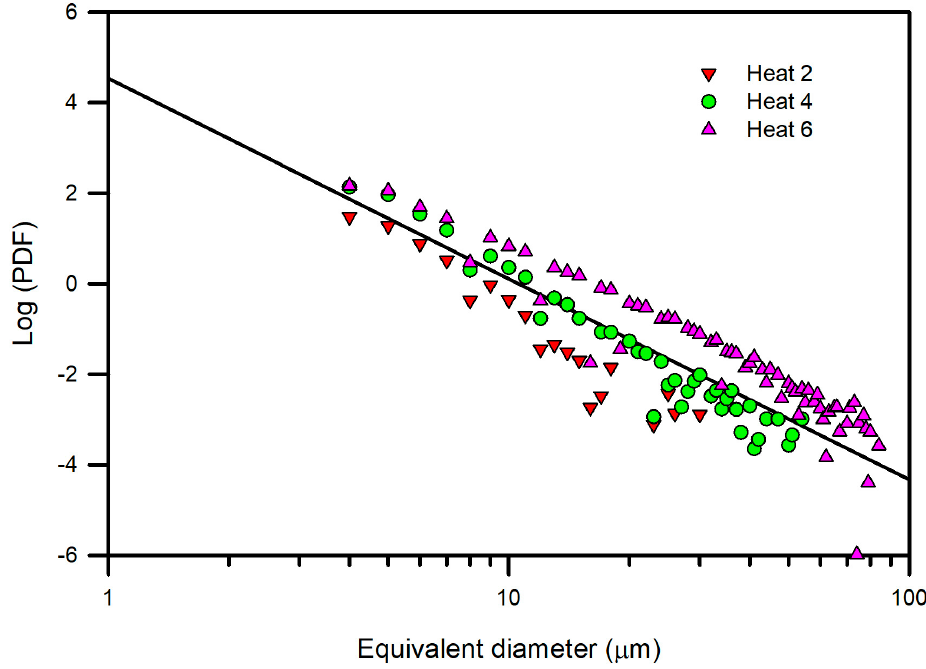
Figure 5. Log-log plot of PDFs versus inclusion equivalent diameter for Heats 2, 4 and